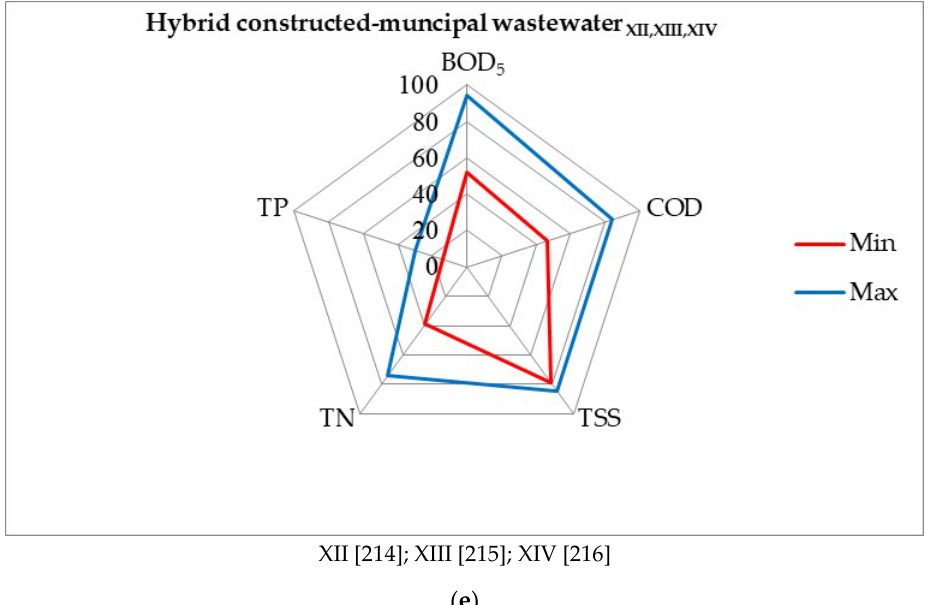
Figure 9. Evaluation of the effectiveness of wastewater treatment systems using P. australis : ( a ) horizontal flow—domestic wastewater, ( b ) horizontal subsurface flow—domestic wastewater, ( c ) vertical flow—domestic wastewater, ( d ) vertical subsurface flow—domestic wastewater, ( e ) hybrid constructed—municipal wastewater.